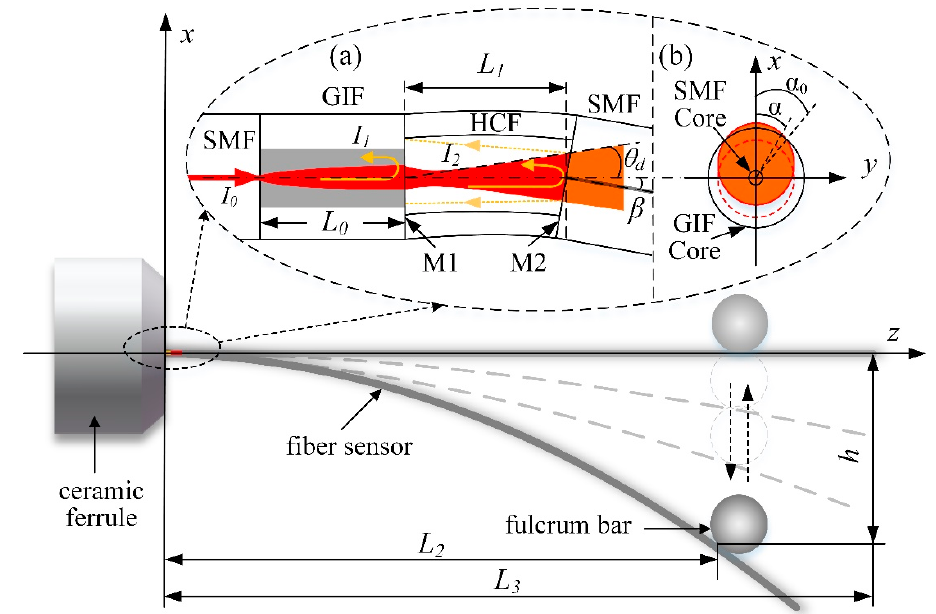
Figure 2. The working principle of the proposed FPI vibration sensor. Insets ( a ): a schematic of the proposed FPI; (GIF: graded index fiber; HCF: hollow-core fiber, SMF: single mode fiber) ( b ): the beam profile on M1.